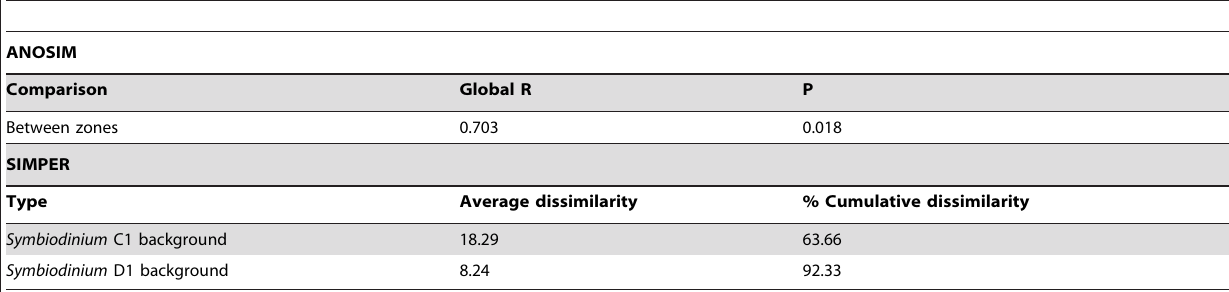
Table 4. Summary of multivariate analyses using ANOSIM and SIMPER of Symbiodinium communities sampled in each of the two zones (inner and outer) along a water quality gradient in the Whitsunday